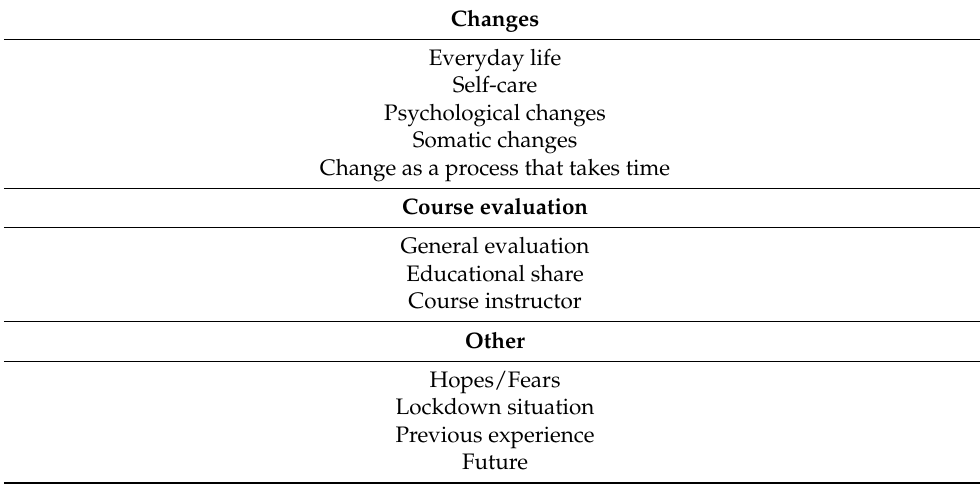
Table 5. Qualitative